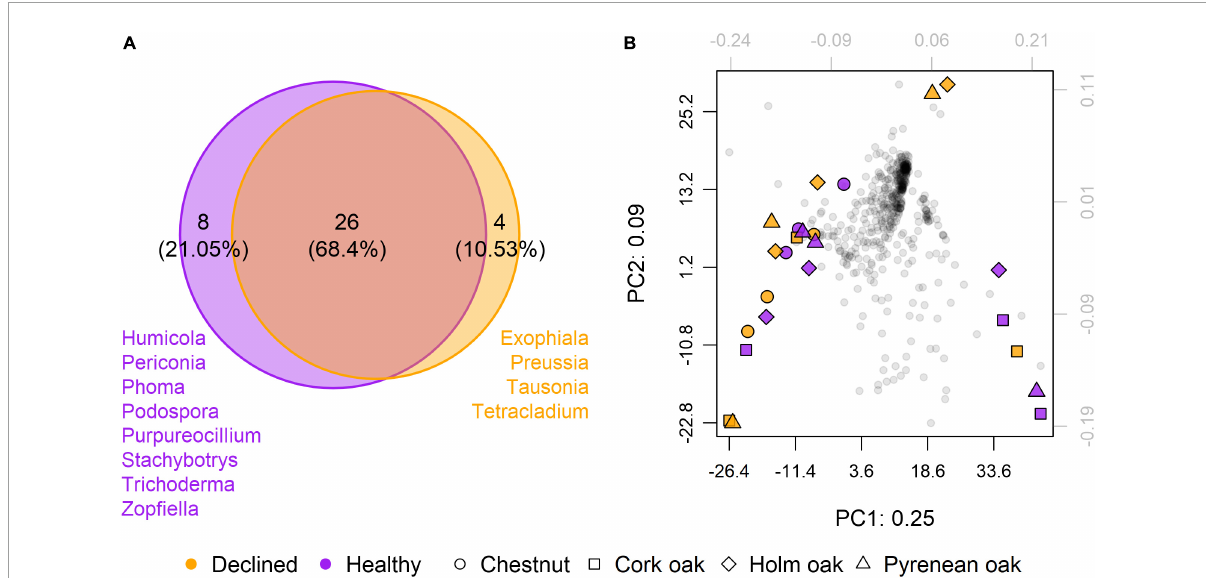
FIGURE4 Overall effect of health status on mycobiota. (A) Venn’s diagram showing the number of common and exclusive genera between samples from healthy ( n = 12) and diseased ( n = 12) trees. Only genera present in at least 10 out of 12 samples per condition are included. (B) Principal components analysis (PCA) of presence/absence based on clr-transformed abundances. Gray dots correspond to genera. Colored dots correspond to samples. Total variance explained by the first two dimensions is 35%.